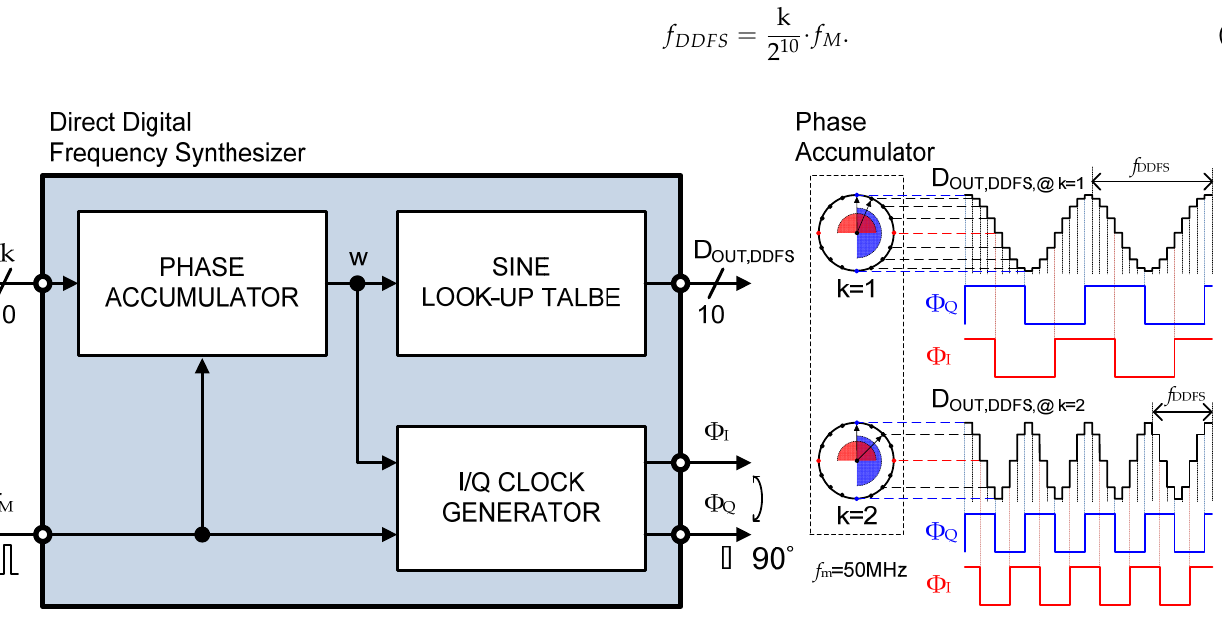
Figure 3. The DDFS block diagram with a principle of DDFS operation.